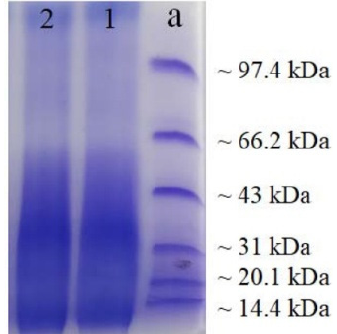
Figure 1. The patterns of electrophoretic separation of standard (line a) and wool keratins (lines 1 and 2).